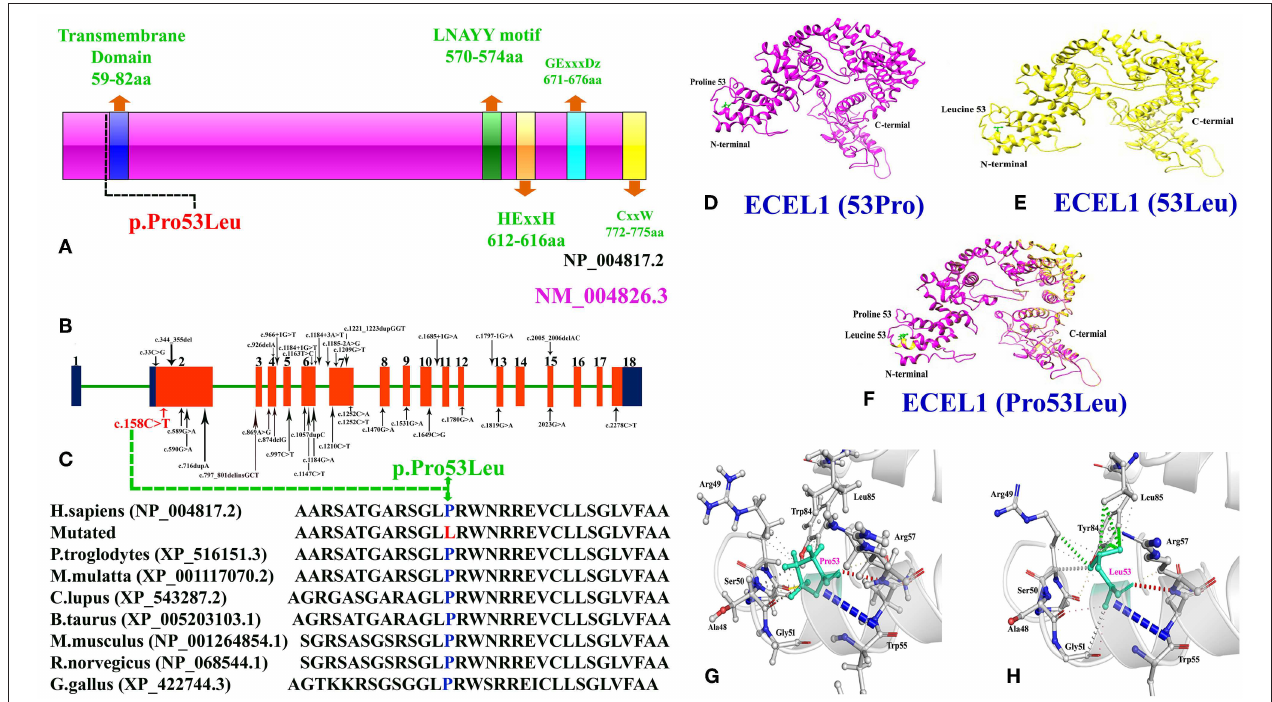
FIGURE 2 | (A) Schematic representation of ECEL1 protein and domains including the transmembrane domain (TM: 59-82aa; exon 2), the LNAYY motif (exon 11) involved in substrate orientation, the HExxH zinc binding motif (exon 13), the GExxxD zinc coordinating motif (exon 15) and the CxxW metalloprotease conserved carboxy terminal sequence (exon 18). The mutation identified in the present case study lie next to the N-terminal transmembrane domain. (B) Cartoonic representation of ECEL1 exons, black arrows represent already reported variants and red arrow represent the variant identified in the present study. Exons and introns are not drawn up to scale. (C) Amino acid sequence comparison of human ECEL1 protein with other orthologs species showing conservation of Pro53 residue across different species. (D) Wild-type ECEL1 protein structure showing Proline at amino acid position 53. (E) Mutant ECEL1 protein structure showing Leucine at amino acid position 53. (F) Representing difference in the protein structure after alignment of both mutant and wild type protein. (G) Close-up view of the wild type Proline 53 and (H) close-up view of the mutant Leucine 53 showing additional